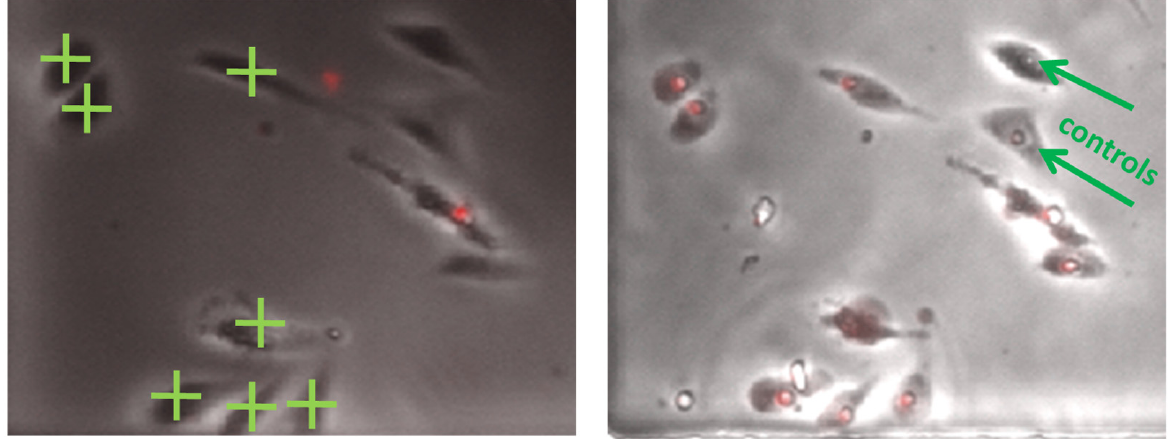
Figure 4 . Demonstration of laser injection to 7 targeted CHO cells for 40 s of laser treatment with a peak power of 24 mW. ( Left ) Image before laser injection to the seven cells indicated by green crosses (i.e., plus signs). ( Right ) Image after laser-induced permeabilization, demonstrating propidium iodide (PI) uptake by the targeted CHO cells (denoted with the red stain) and no PI uptake by the two control cells (labeled with green arrows as controls). The physical size of these data panels is ≈ 275 μ m × 300 μ m.